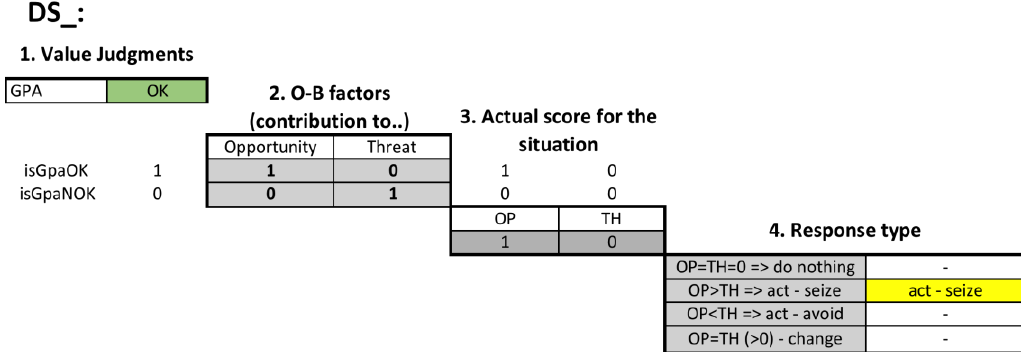
Figure 10. Optimizing-balancing for the appreciation statechart of the